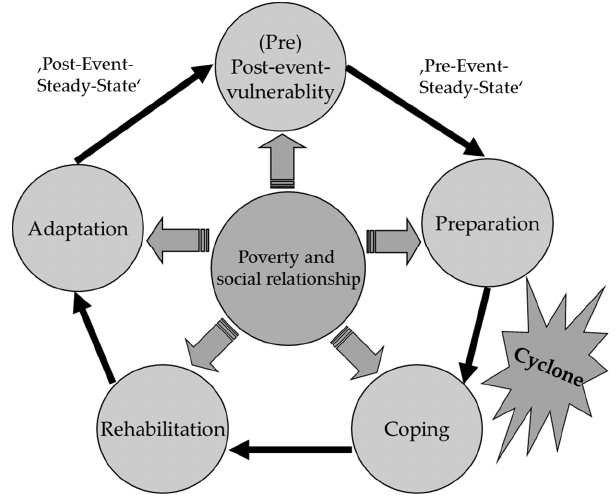
Figure 2. State-and-Transition Model in disaster resilience, adopted from Mallick [2].